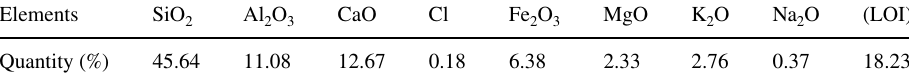
Table 2 Chemical composition of the mud